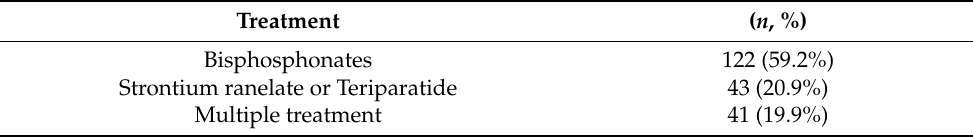
Table 3. Prior anti-osteoporotic treatment ( n = 206/332,